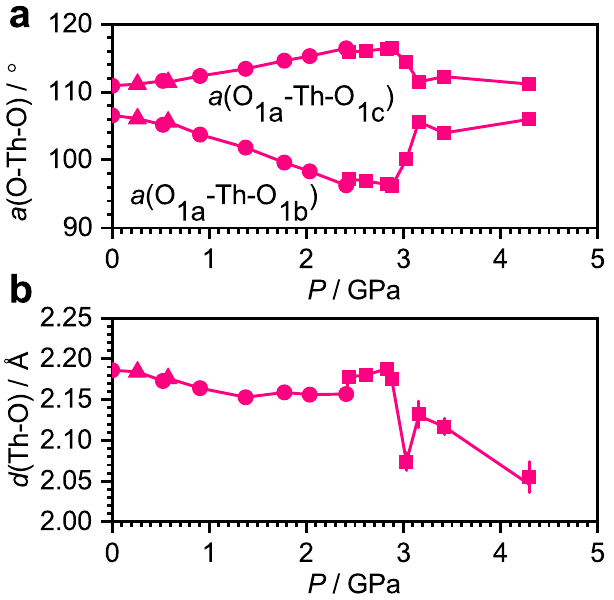
Fig.4|Thein fl uenceofpressureonthestructuralparametersofTh(OAr) 4 . Data obtainedwithhydrostaticmediaFluorinertFC70,Daphne7373and1:1pentaneand isopentane are shown as triangles, circles and squares, respectively. a The two unique O-Th-O angles of the ThO 4 unit (see Fig. 1 for labels). b The Th-O distance. PlotsfortheUandNpderivativesareavailableinSupplementaryFig.10,whichalso includes data for the M-O-C angles and M-O-C-C torsion angles. Error bars taken fromthecrystallographicstructurere fi nementsareplotted,butaremostlysmaller than symbols used for the data points.